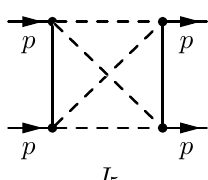
Figure 4 . Master integrals. Solid lines correspond to the propagators 1 = ( k 2 (cid:0) 1), dashed | to 1 =k 2 . The momentum p is on mass shell, p 2 =